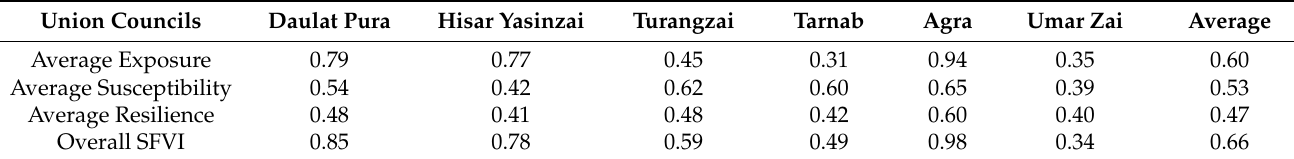
Figure 11. Overall social vulnerability map. Table 7. Overall social vulnerability to Table 7. Overall social vulnerability to floods.